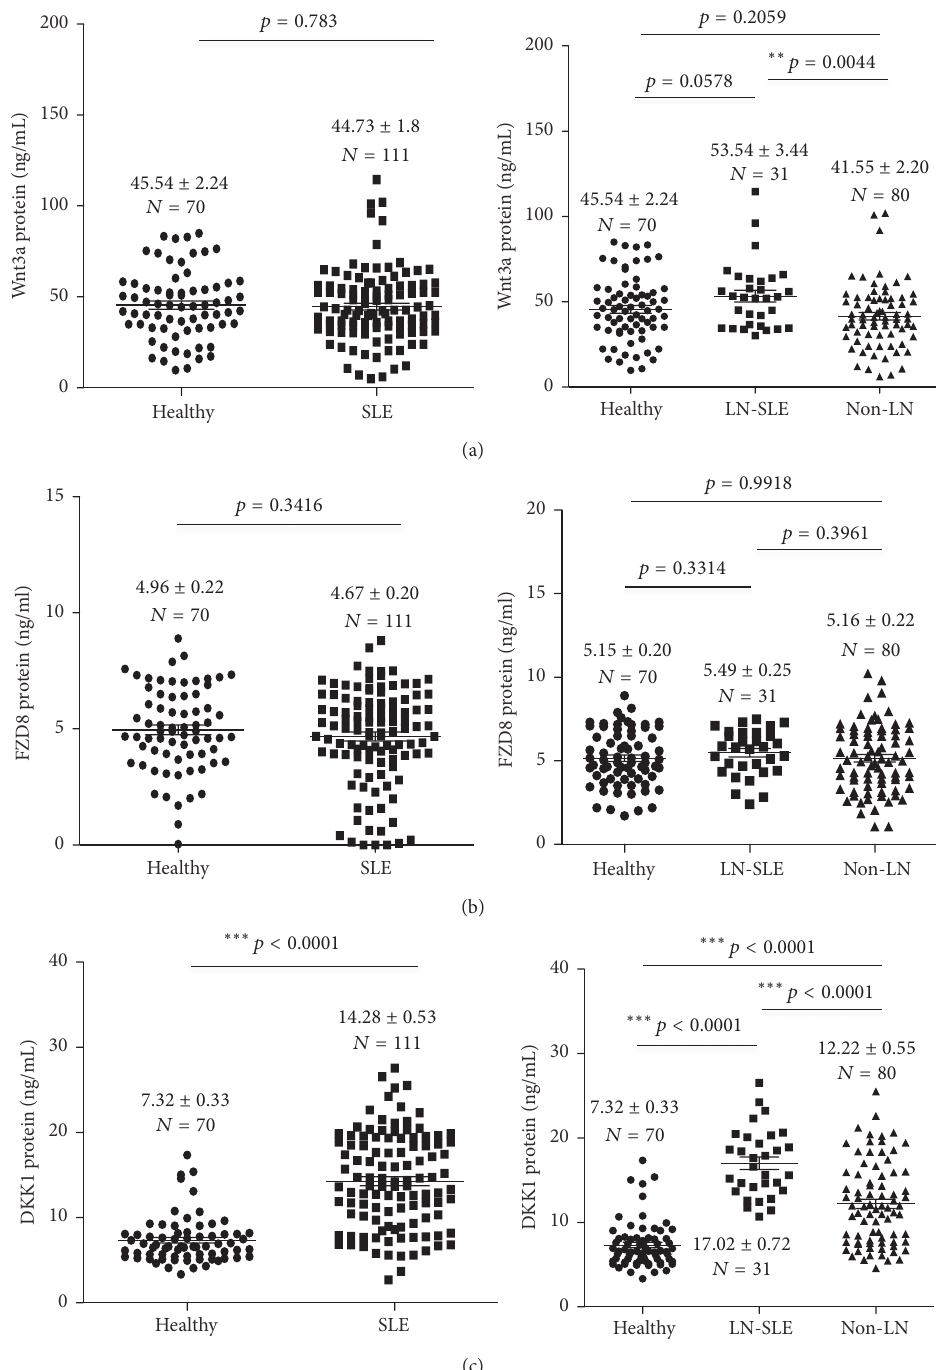
Figure 1: The serum concentrations of Wnt-3A, FZD-8, and DKK-1 proteins in healthy individuals and SLE patients. (a) The concentration of serum Wnt-3A protein in healthy individuals and SLE patients. No statistical difference was determined between healthy individuals and SLE patients (left panel), but more abundant Wnt-3A protein was found in sera of SLE patients with renal involvement (LN-SLE) compared with non-LN-SLE patients (right panel, 𝑝 = 0.0044 ). (b) The concentration of serum FZD-8 protein in healthy individuals and SLE patients. No statistical difference was determined between healthy individuals and SLE patients (left panel), and LN-SLE and non-LN-SLE patients (right panel). (c) The concentration of serum DKK-1 protein in healthy individuals and SLE patients. Statistical differences were found between healthy individuals and SLE patients (left panel, 𝑝 < 0.0001 ), LN-SLE ( 𝑝 < 0.0001 ) and non-LN-SLE patients (right panel, 𝑝 < 0.0001 ). More abundant serum DKK-1 protein was detected in LN-SLE patients relative to healthy individuals and SLE patients without renal flare, and the highest level of serum DKK-1 protein was determined in LN-SLE patients. Bars indicate the average levels of indicated proteins in each group. Compared with the respective healthy and non-LN groups, ∗∗ 𝑝 < 0.01 and ∗∗∗ 𝑝 < 0.001 . Data presents as the mean ± SEM in each